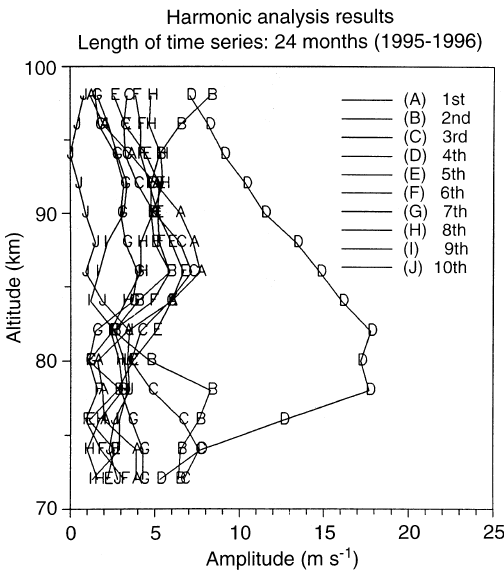
Fig 6. Harmonic analysis results for the mean zonal over a period of two years – First ten